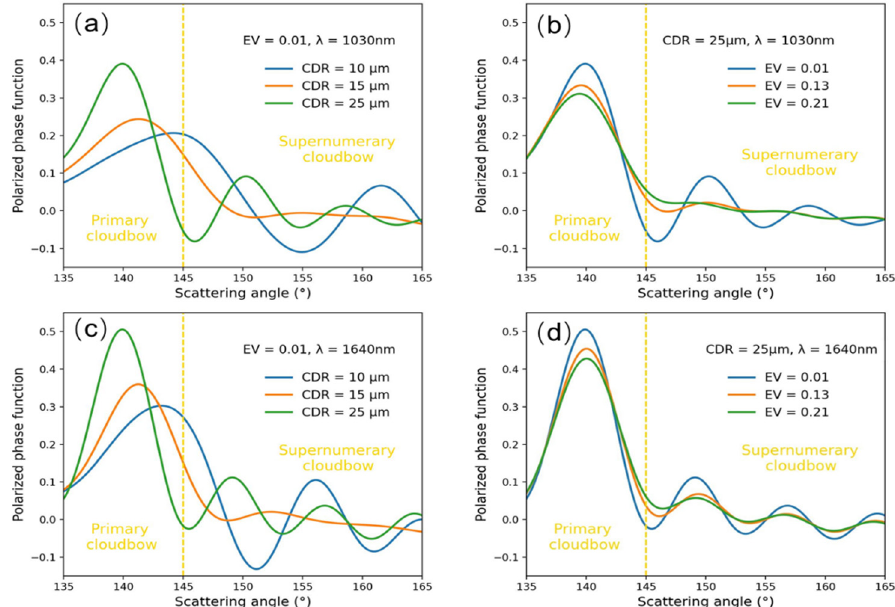
Figure 6. Simulations of the polarized phase function for different ( a ) cloud droplet effective radii (CDR) and ( b ) variance values (EV) for 1030 nm, as well as different ( c ) CDR and ( d ) EV for 1640 nm. The scattering range consists of the primary cloudbow (135°–145°) and supernumerary cloudbows (145°–165°).